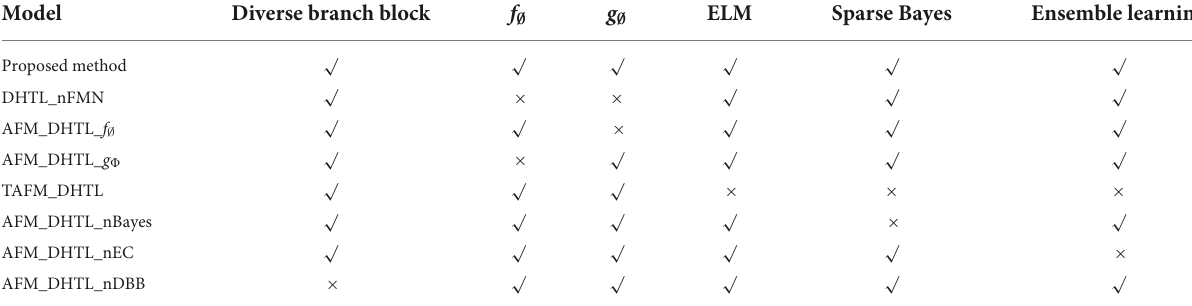
TABLE 4 Ablation experiment of the structure of the model.